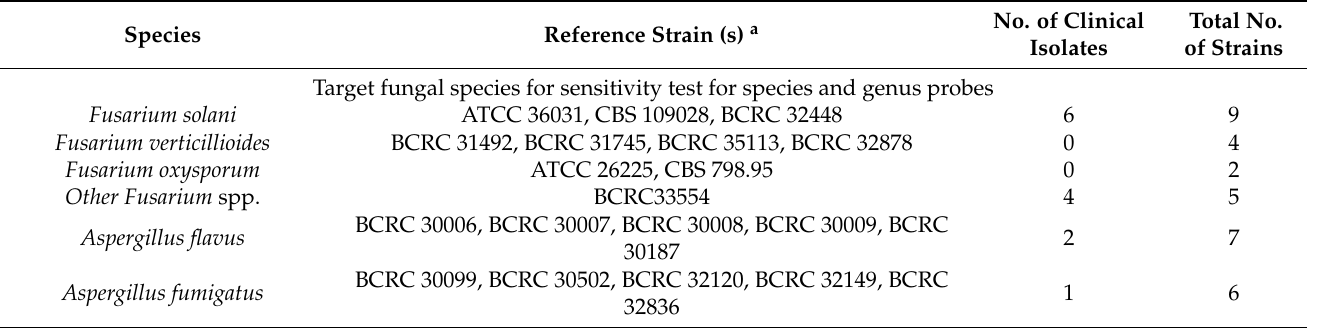
No. of Clinical Total No. Isolates of Strains